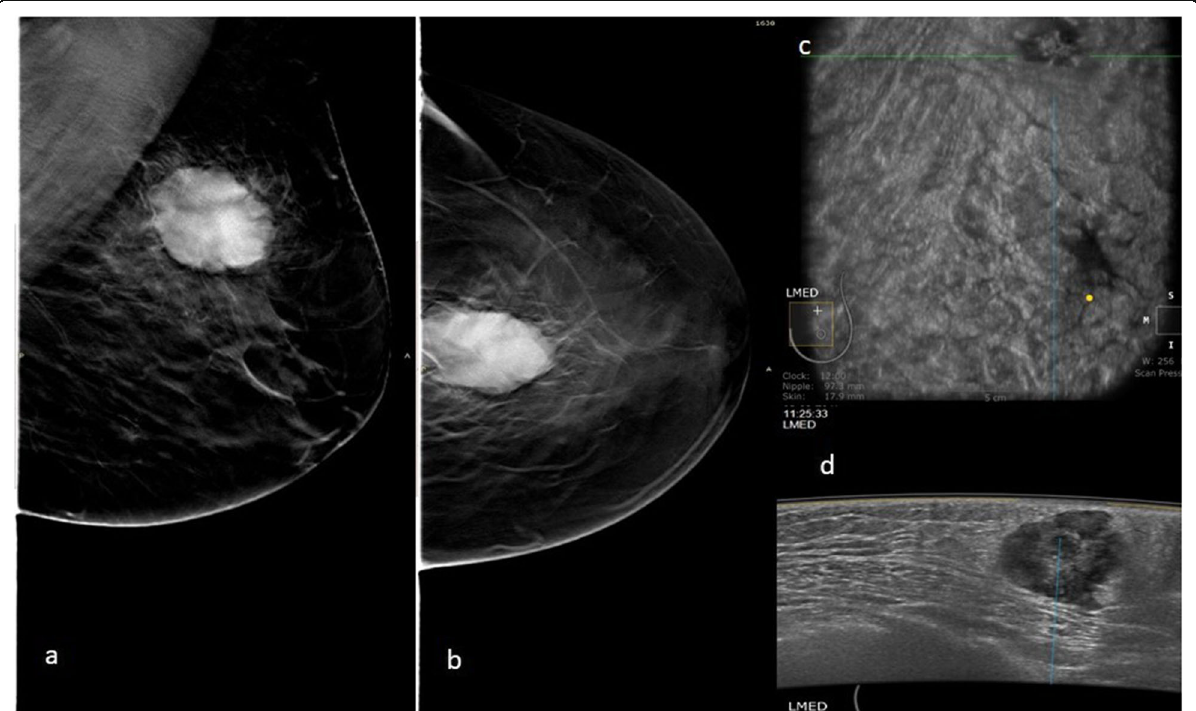
Fig. 1 A 51-year-old female patient was presented with a left UOQ breast lump. a , b Digital breast mammography tomosynthesis MLO and CC views of the left breast show an oval-shaped micro lobulated high-density mass at UOQ with no skin thickening (BIRADS IV). Automated ultrasound left medial coronal image ( c ) shows focal irregular defect with retraction phenomena at distance 97.3 mm from the nipple. Automated ultrasound left medial axial image ( d ) shows an irregular shaped mass with spiculated margin, non-parallel orientation, and heterogeneous echo pattern (BIRADS IV). A core biopsy was done and revealed invasive duct carcinoma. Automated ultrasound was superior to tomosynthesis in the characterization of this lesion by detection of the fine